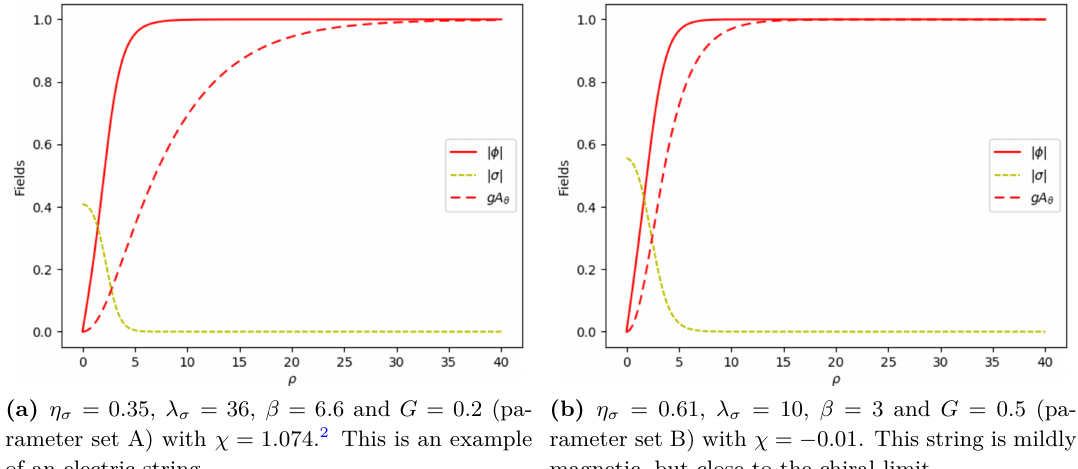
Figure 1 . Straight string profiles for two different parameter sets. Notice that the length scales associated with the vortex and condensate fields are roughly the same while the range of the gauge field is different and can be reduced by increasing G